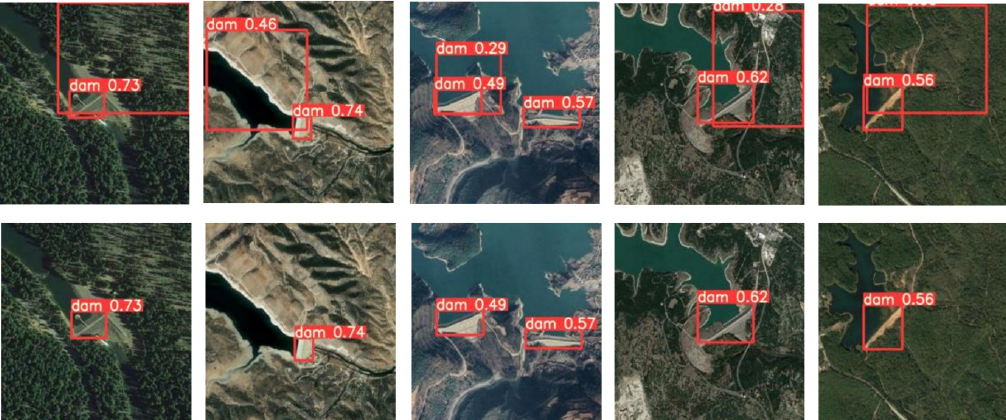
Figure 11. Confusion matrixes for different NMS algorithms on the RSDams ( left ) and DIOR Dams ( right ) test sets.